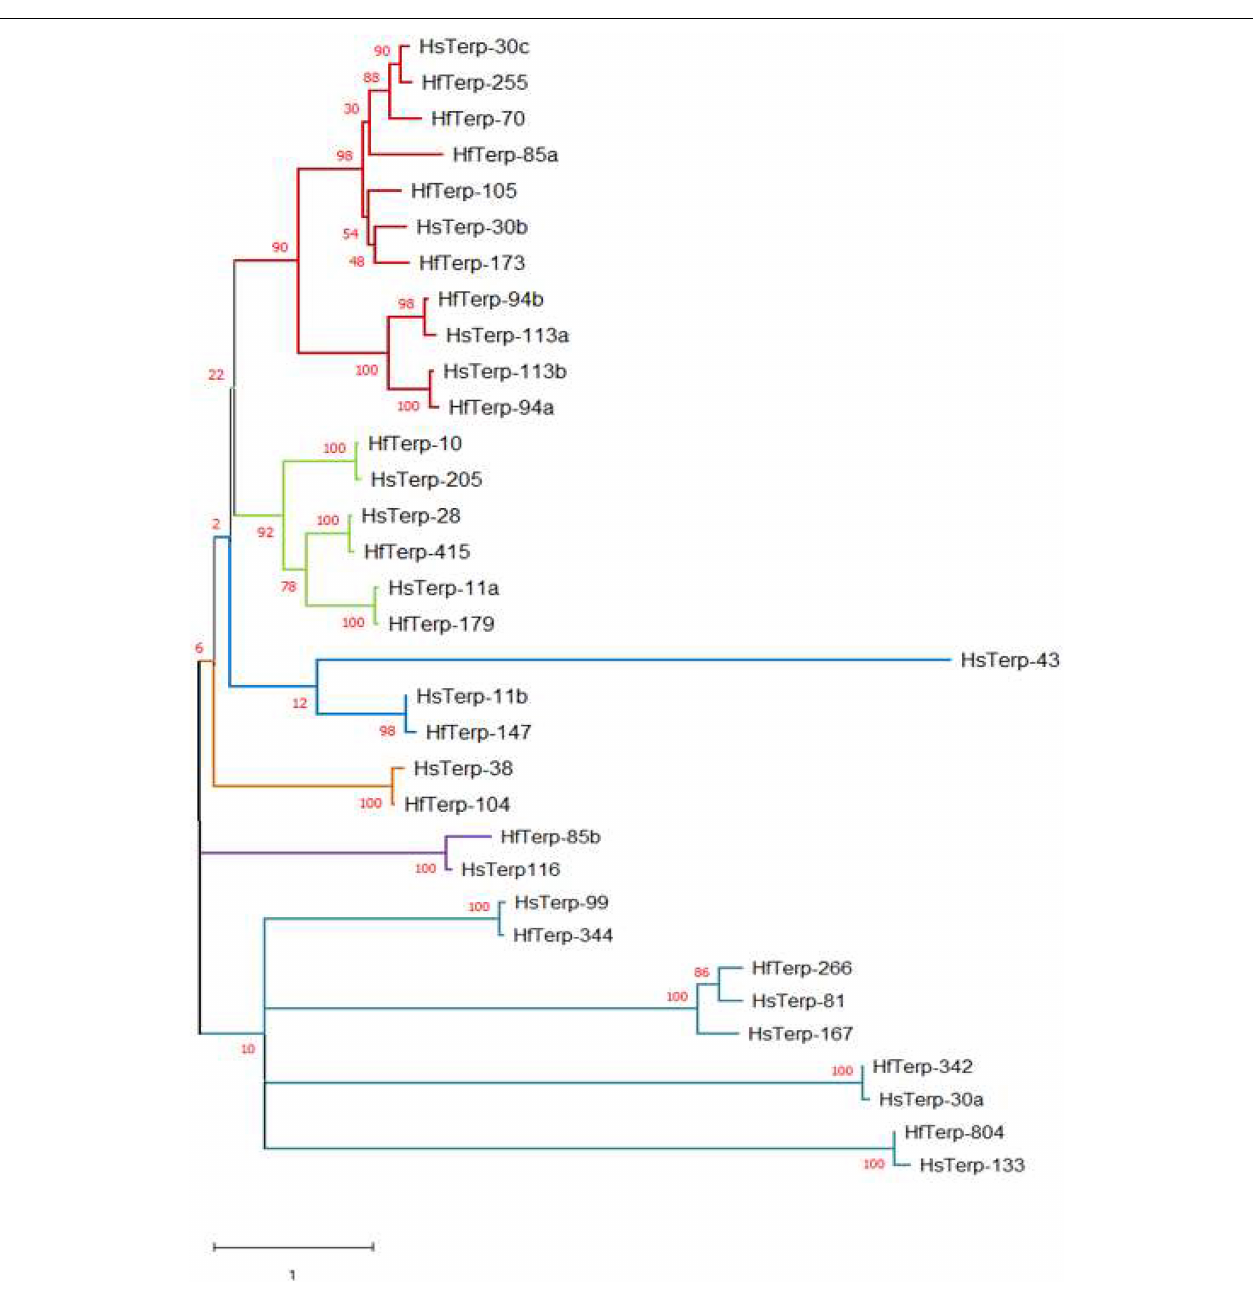
FIGURE 4 | Maximum likelihood tree of putative terpene synthases from Hypholoma fasciculare and Hypholoma sublateritium . Contigs or scaffold numbers are shown adjacent to species abbreviations . The evolutionary history was inferred by using the maximum Likelihood method and the Whelan and Goldman model conducted in MEGA X. The percentages of trees in which the associated taxa clustered together are shown next to the branches